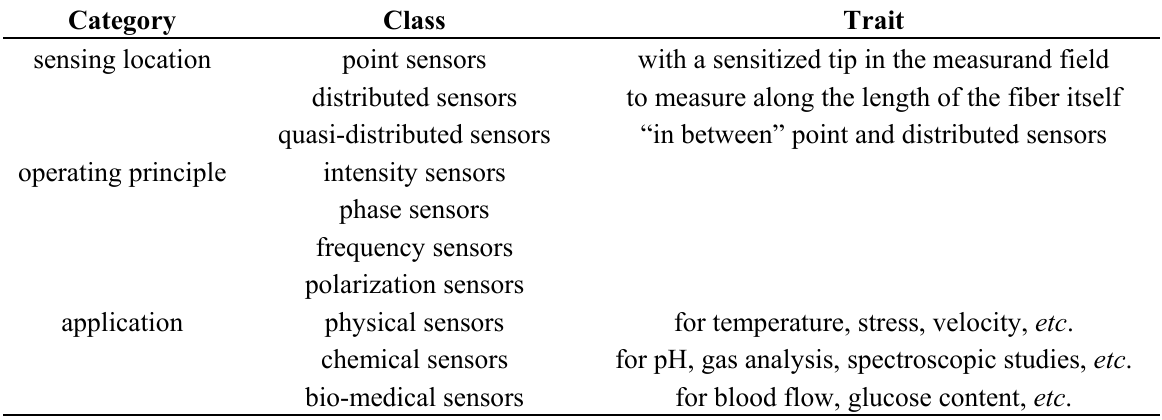
Table 1. Fiber-optical sensor classifications under three